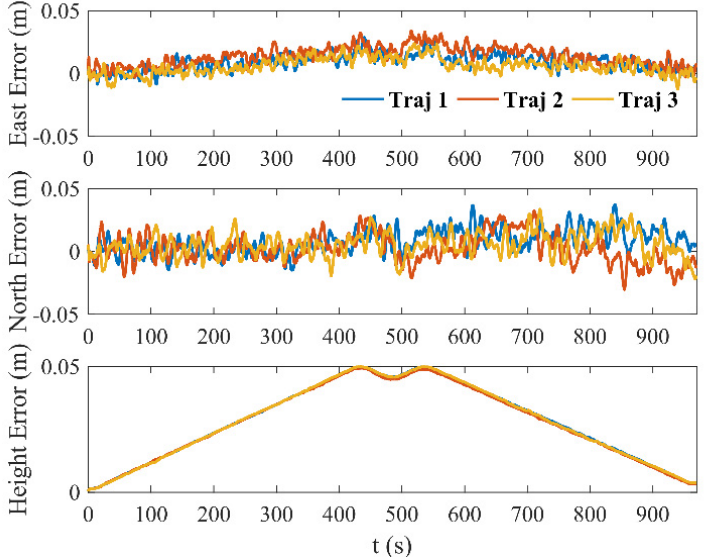
Figure 10. Positioning errors under different trajectory curvatures.